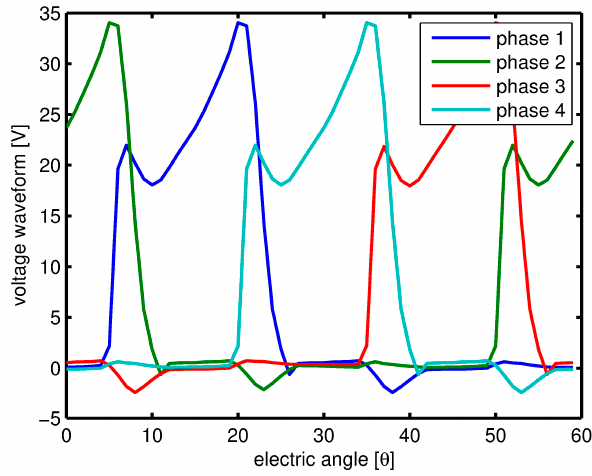
Figure 6. Current waveform for the TSF method with an exponential current waveform.